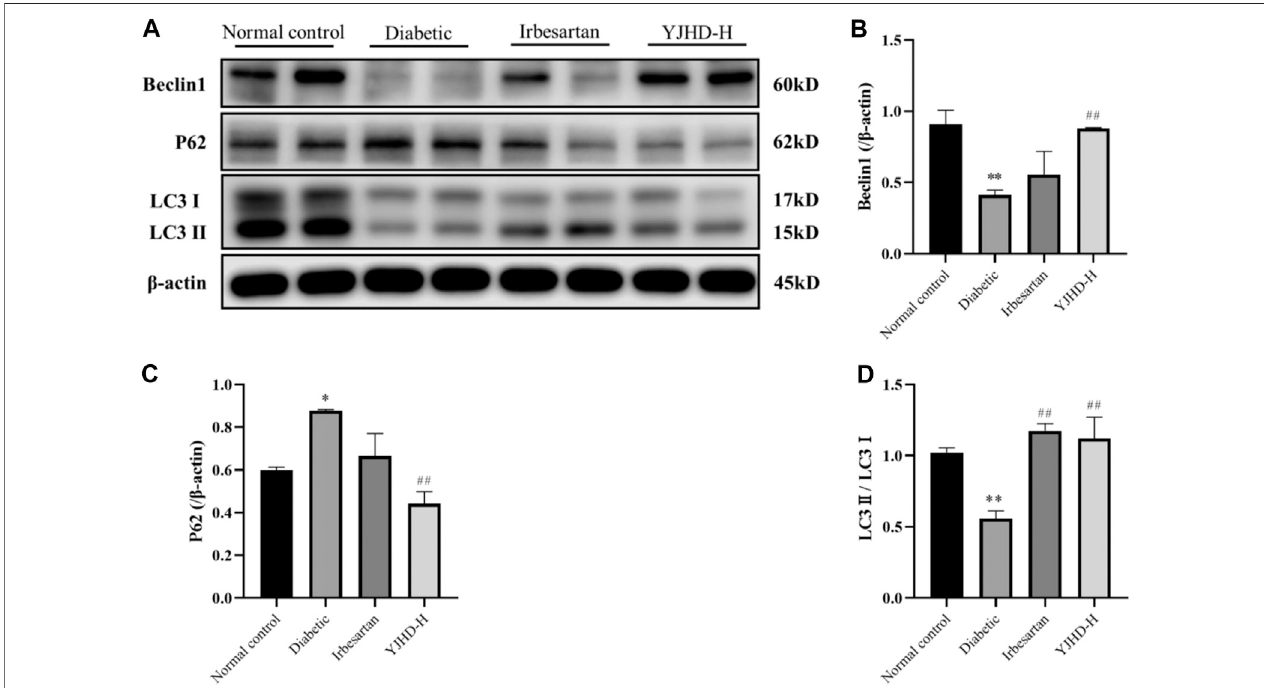
FIGURE 6 | Effects of Yiqi Jiedu Huayu decoction (YJHD) on autophagy. (A) Protein levels of Beclin-1, p62, and LC3II were detected by western blotting. (B – D) Proteinconcentrationanalysis.Dataareexpressedas* p < 0.05,** p < 0.01:comparedwiththenormalcontrolgroup,respectively;# p < 0.05,## p < 0.01:comparedwith the diabetic